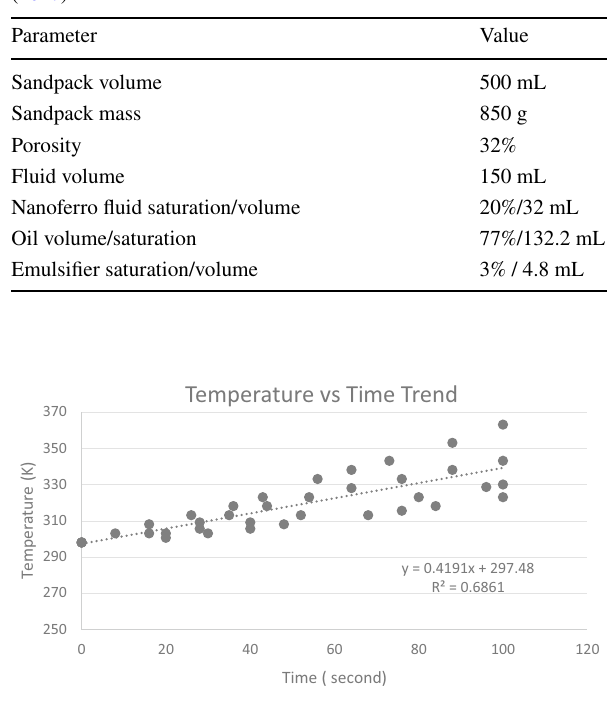
Fig. 4 Sandpack configuration. Reproduced from Indriani et al. y = 1E+14x -6.112 R² = 0.9998 Table 1 Sandpack design parameter. Reproduced from Indriani et al.